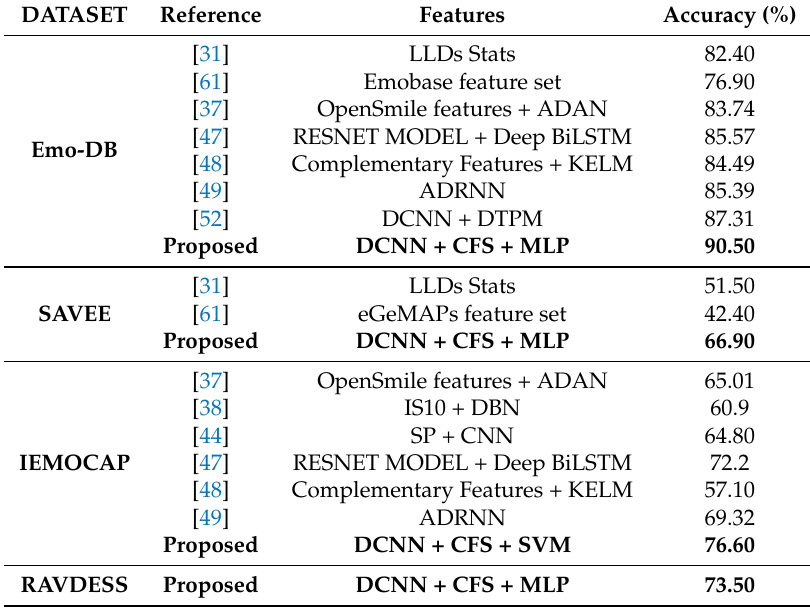
Table 6. Comparison of speaker-independent experiments with state-of-the-art approaches.